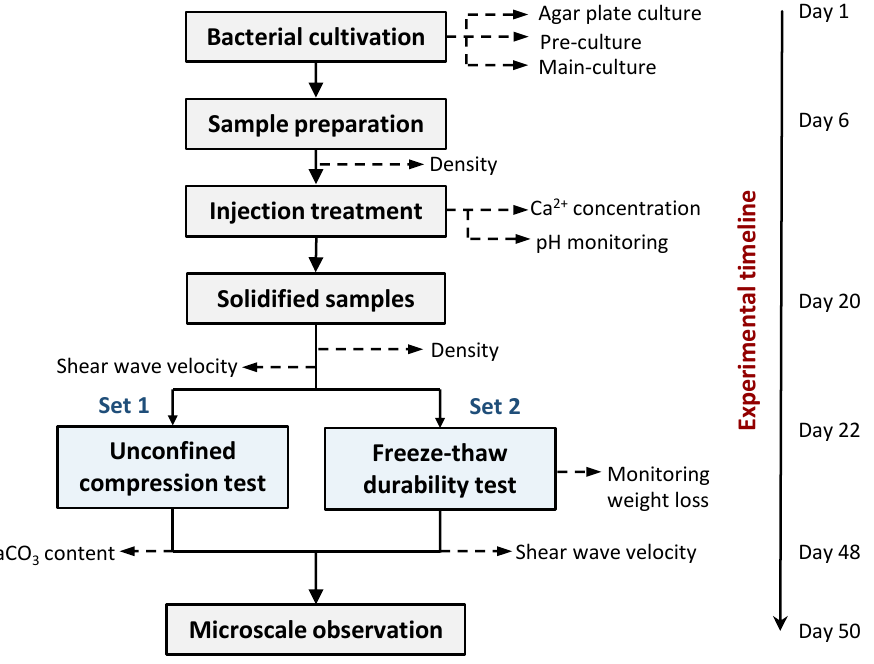
Figure 4. Experimental flow of this laboratory-scale study.